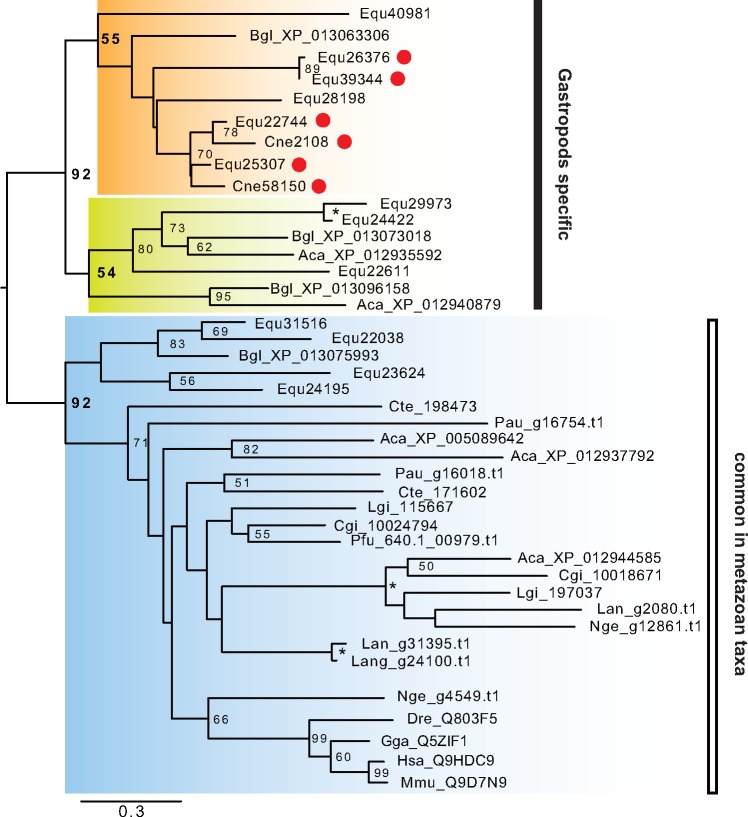
—Phylogeny of adipocyte plasma membrane-associated like proteins in various metazoan taxa. The maximum likelihood tree was inferred from 43 APMAP-like gene sequences under the LG  +  Γ + I model (352 positions of the strictosidine synthase domain, 100 bootstrap replicates). Bootstrap support values <50% are not shown. Asterisks indicate 100% bootstrap support. Branch lengths are proportional to the expected number of substitutions per site, as indicated by the scale bar. Red circles indicate proteins that have been identified as SMPs in this or previous studies. Aca, Aplysia california; Bgl, Biomphalaria glabrata; Cgi, Crassostrea gigas; Cne, Cepaea nemoralis; Cte, Capitella teleta; Dre, Danio renio; Equ, Euhadra quaesita; Gga, Gallus gallus; Hsa, Homo sapiens; Lan, Lingula anatina; Lgi, Lottia gigantea; Mmu, Mus musculus; Nge, Notospermus geniculatus; Pau, Phoronis australis; Pfu, Pinctada fucata.